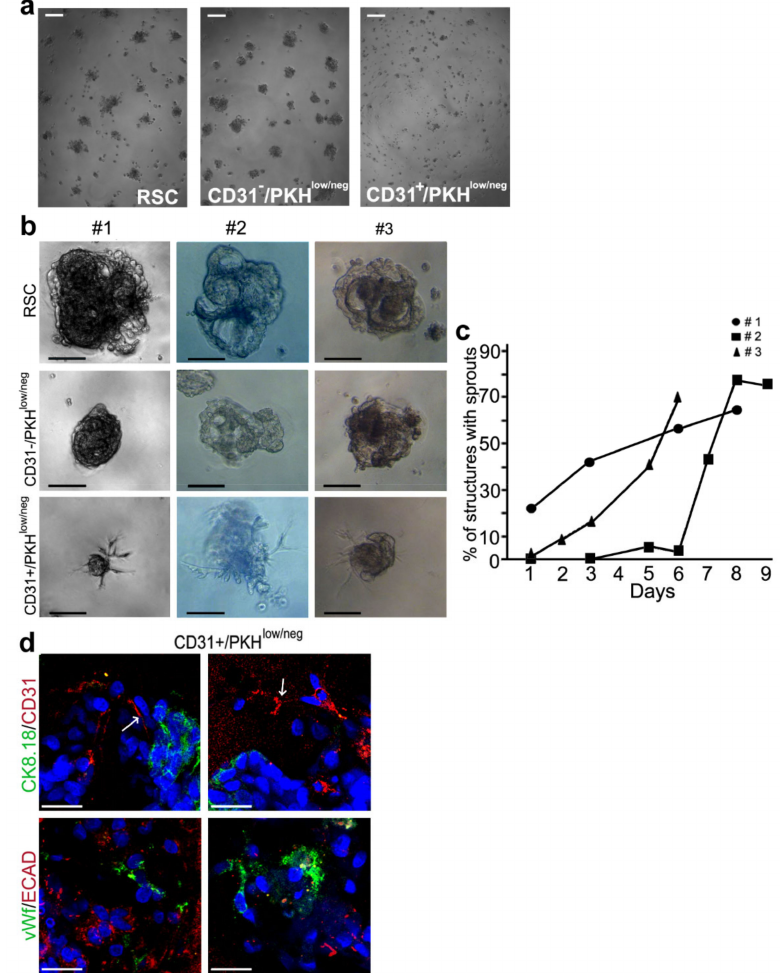
Figure 4. Morphogenesis 3D assay. ( a ) Contrast-phase images of RSC (left), CD31 − / PKH low / neg (middle) and CD31 +/ PKH low / neg (right) at 6 h of culture. Scale bars, 100 µ m; ( b ) contrast-phase images of structures obtained in Matrigel at 6–7 days of culture from the 3 di ff erent samples #1, #2, #3 of RSC (top), CD31 − / PKH low / neg (middle), CD31 +/ PKH low / neg (bottom). Scale bars, 100 µ m; ( c ) percentage of structures with sprouts in the three di ff erent samples of CD31 +/ PKH low / neg at di ff erent time points; ( d ) 3D IF staining of the structures obtained from CD31 +/ PKH low / neg cells with the antibodies against the indicated markers. Two di ff erent fields for each staining are shown. CK: cytokeratin; ECAD: E-cadherin; vWf: von Willebrand Factor; Blue—DAPI. Original magnification 400 × . Scale bars, 50 µ m. Arrows: CD31 + cells in the sprout-like